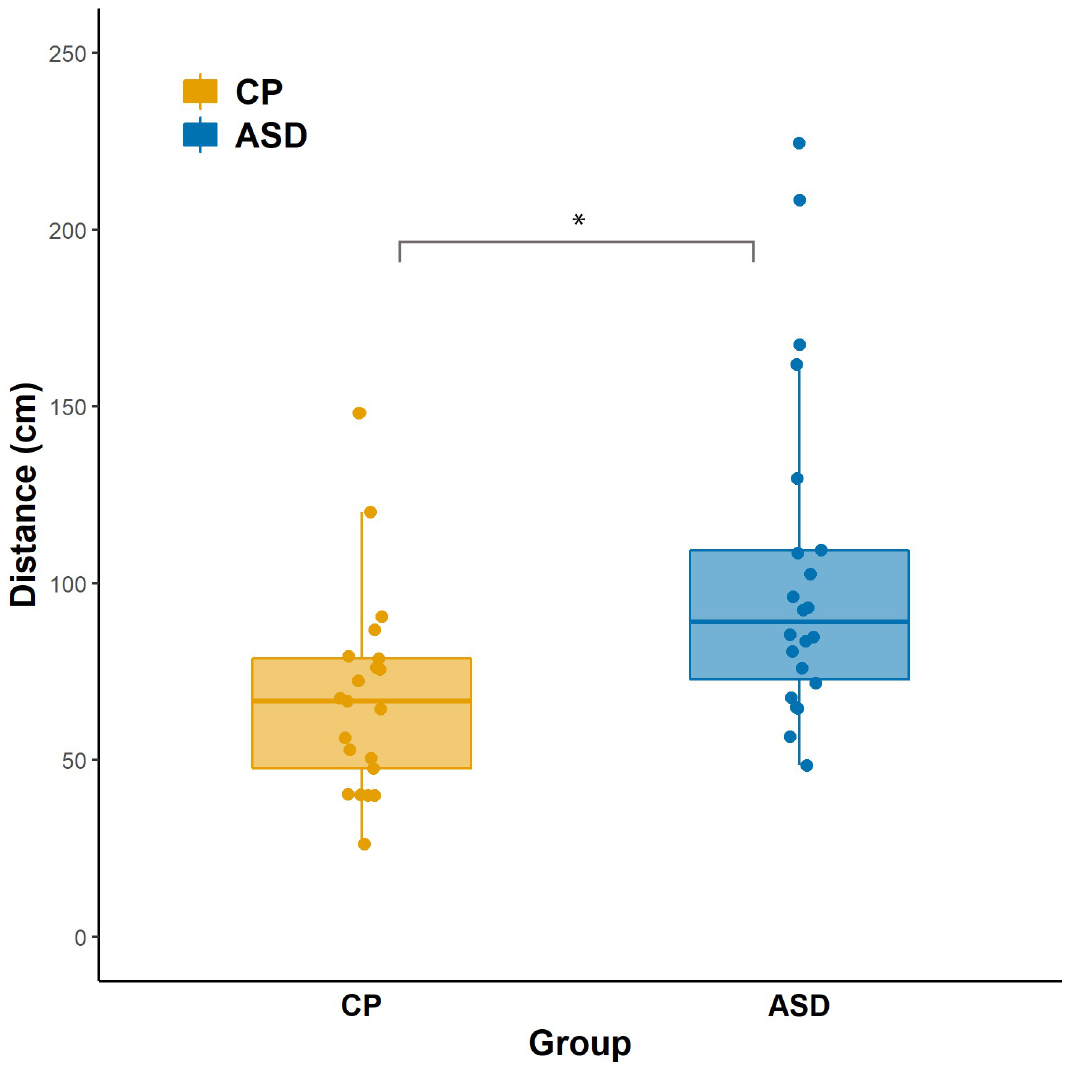
Fig 2. Interpersonal distance in cm. Dots represent the mean of distance data of eight conditions for each individual. The top and the bottom of the box show the upper (Q3) and lower (Q1) quartiles, the line dividing the box represents the median, and notches show a 95% confidence interval around the median. Asterisks indicate significant group differences. Orange: control participants, blue: participants with ASD.